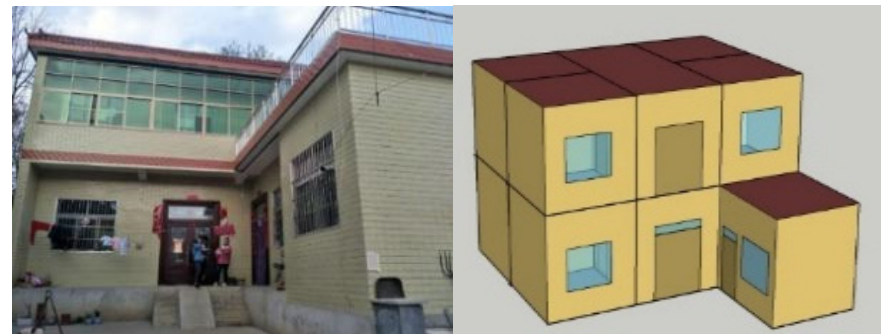
Figure 5. The typical building and the Energy Plus model diagram.